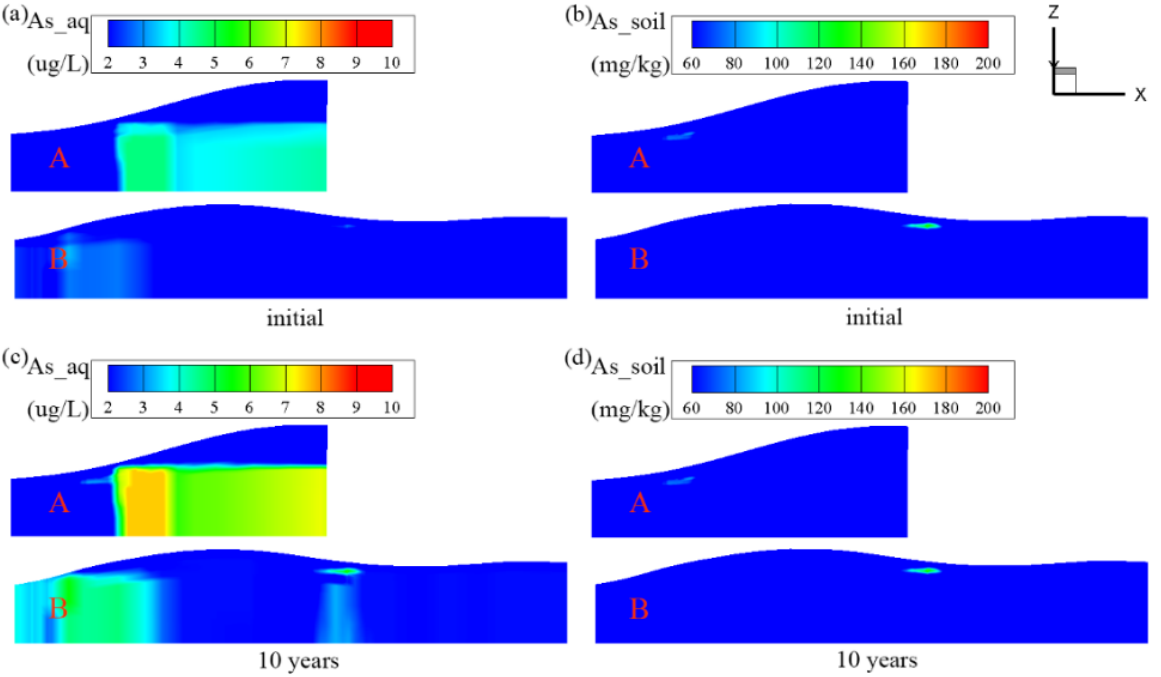
Figure 5. Initial distributions of As concentration in groundwater ( a ) and in soil ( b ), The simulated distributions of As concentrations in groundwater ( c ) and in soil ( d ) after 10 years of the partial excavation of highly contaminated soil (scenario 2). Here, As_aq and As_soil represented groundwater arsenic concentration, soil arsenic concentration, respectively.